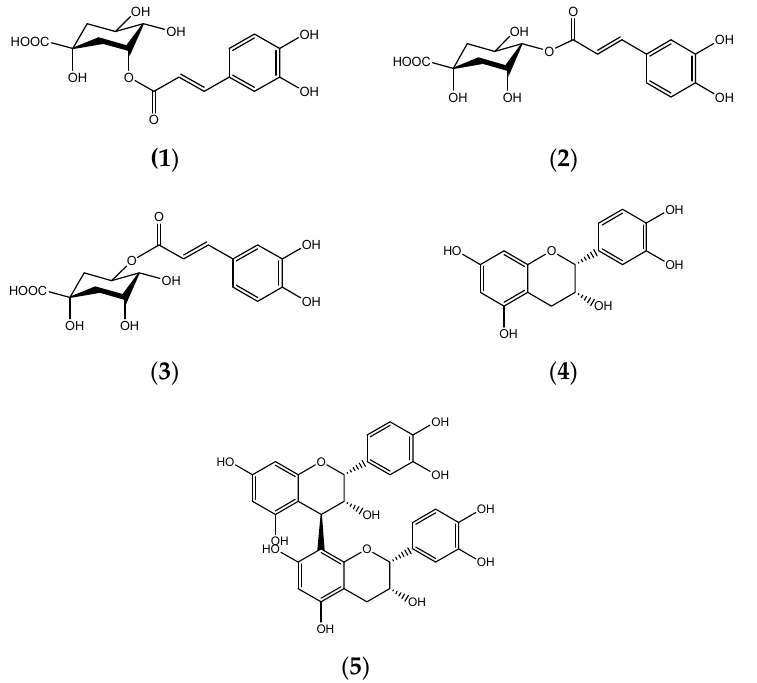
Figure 3. Chemical structures of 3-O-caffeoyl quinic acid ( 1 ), 4-O-caffeoyl quinic acid ( 2 ), 5-O-caffeoyl quinic acid (chlorogenic acid) ( 3 ), epi-catechin ( 4 ), and procyanidin B2 ( 5 ).